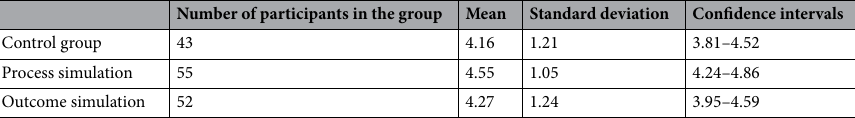
Table 1. Sample size, means, standard deviations and confidence intervals in each